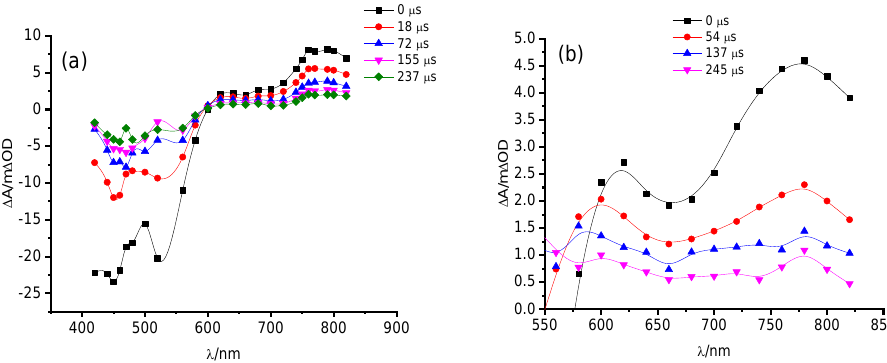
Figure 7. ( a ) Absorption spectra on TiO 2 for Z907 (black line), 2 (Ru(TMAM)-Ag + ) (purple line), 3 (2Z907-Ag + ) (red line), and 4 (2Z907-Ag + -Ru(TMAM)) (blue line). ( b ) Dyes loading onto TiO 2 calculated with the ε data reported in Table 1.